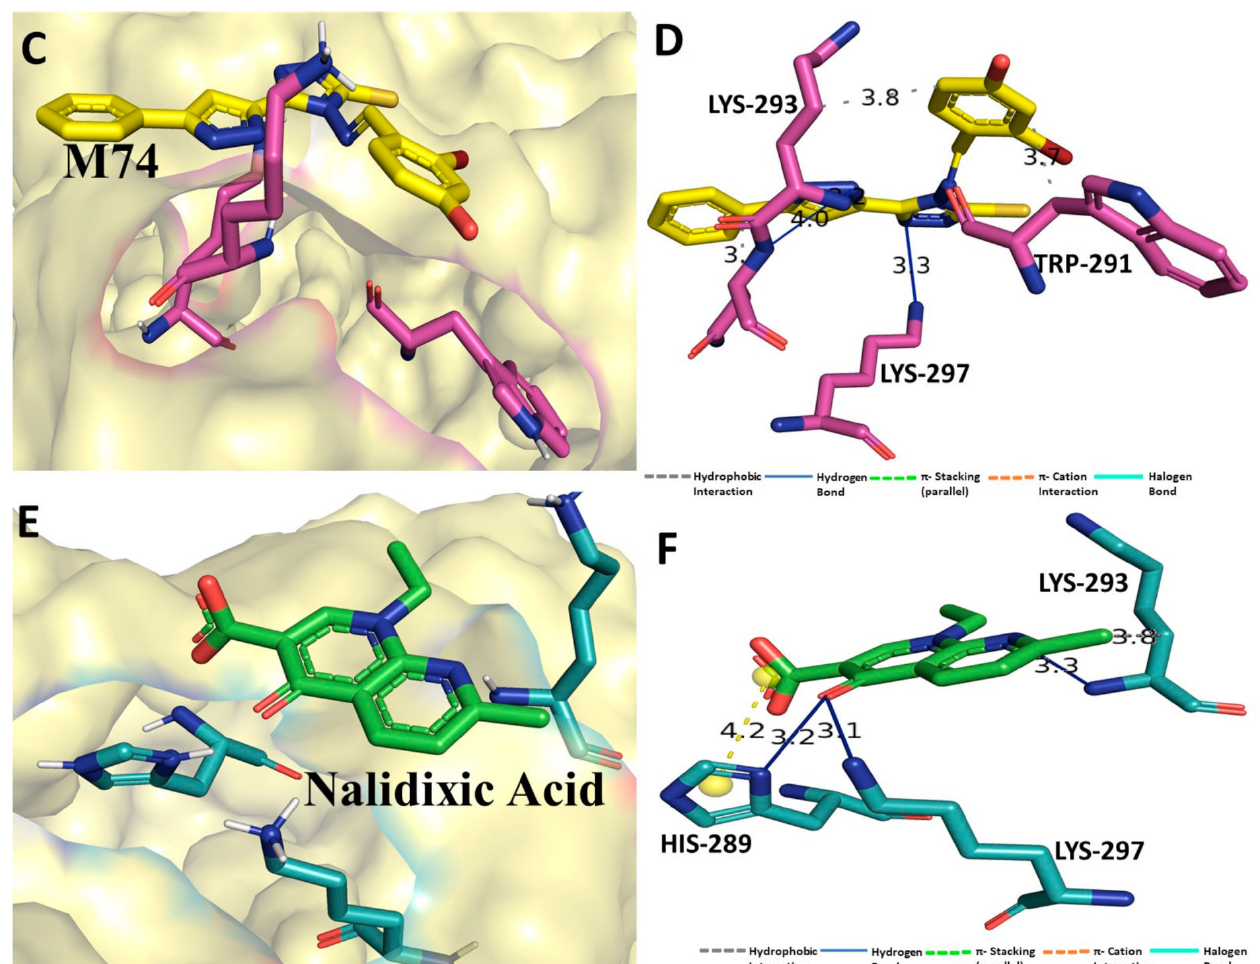
Figure 2. ( A ) Molecular docking-generated binding orientations of standard compound (nalidixic acid) and the proposed pyrazole-based inhibitor compound M74 in complex with CRMP2 (6JV9) protein; ( B ) close-up binding interaction view exhibiting similar binding pattern of all the compounds at the active site cavity of CRMP2 (6JV9) protein; ( C ) binding mode of pyrazole compound M74 in the active site cavity of CRMP2 (6JV9) displayed in surface view representation; ( D ) molecular binding interaction and orientation of compound M74 with CRMP2 (6JV9) protein; ( E ) binding mode of standard compound (nalidixic acid) in the active site cavity of CRMP2 (6JV9) displayed in surface view representation; ( F ) molecular binding interaction and orientation of nalidixic acid with CRMP2 (6JV9)